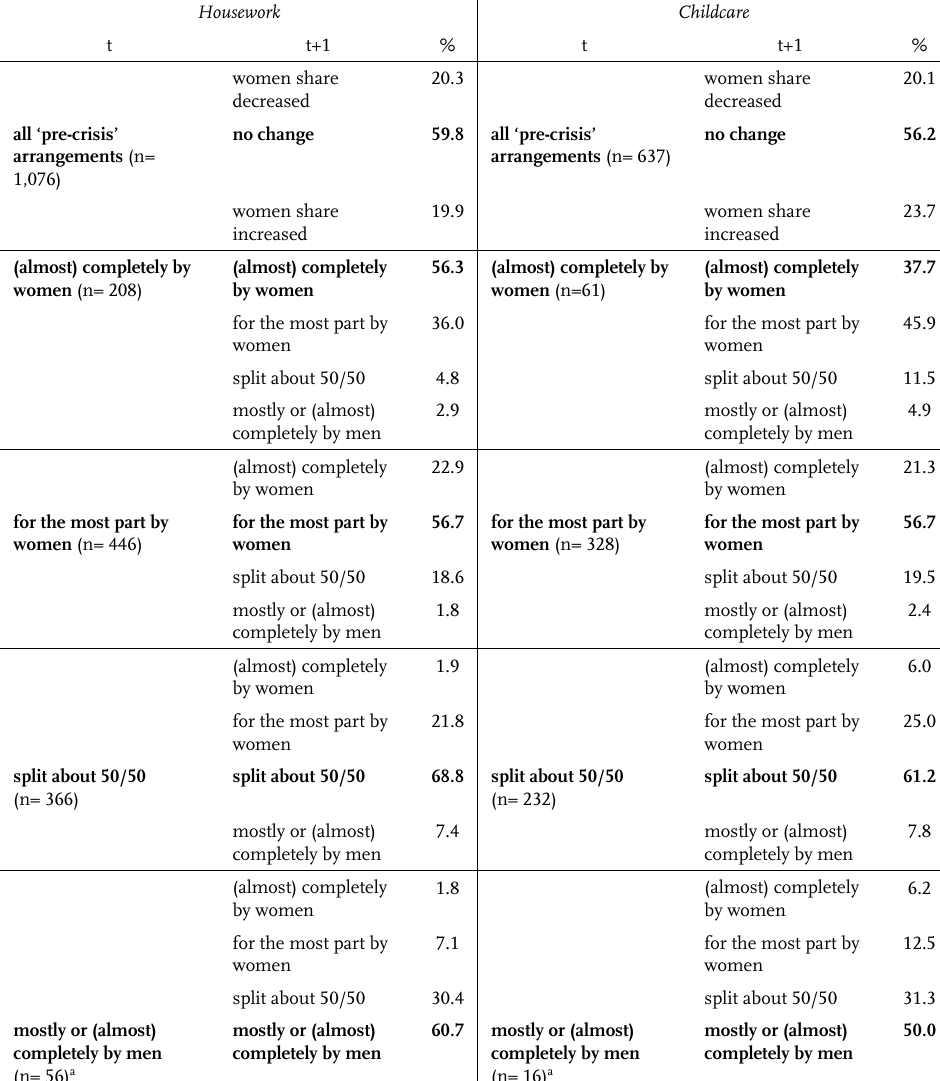
Table 2 : Couples’ division of housework and childcare during the Corona crisis (t+1), by ‘pre-crisis’ arrangement